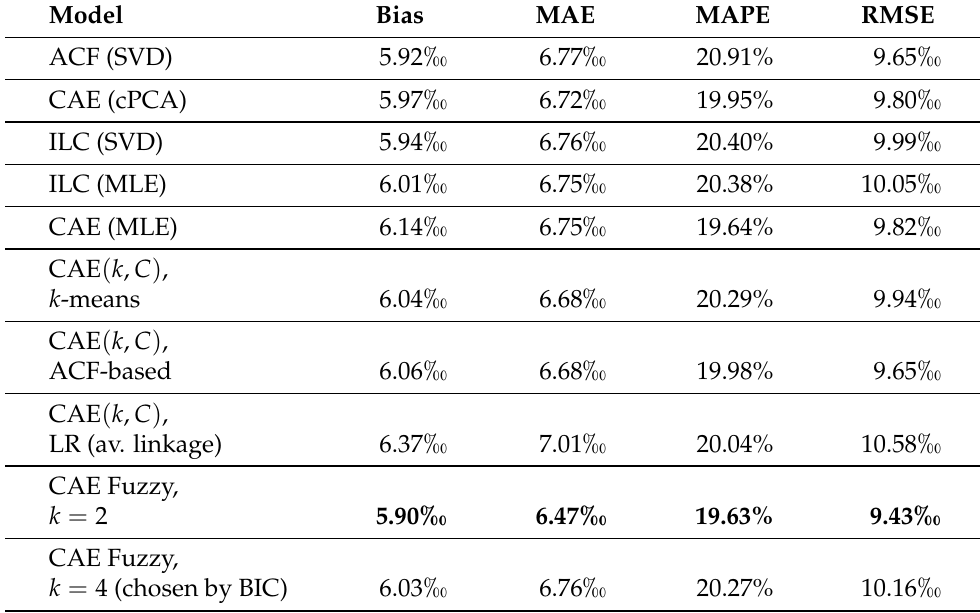
Table 3. Out-of-sample error measures for males aged 53 to 87 in 10 countries between 1988 and 2007 (trained on 1948 to 1987). Best values in each column are marked in